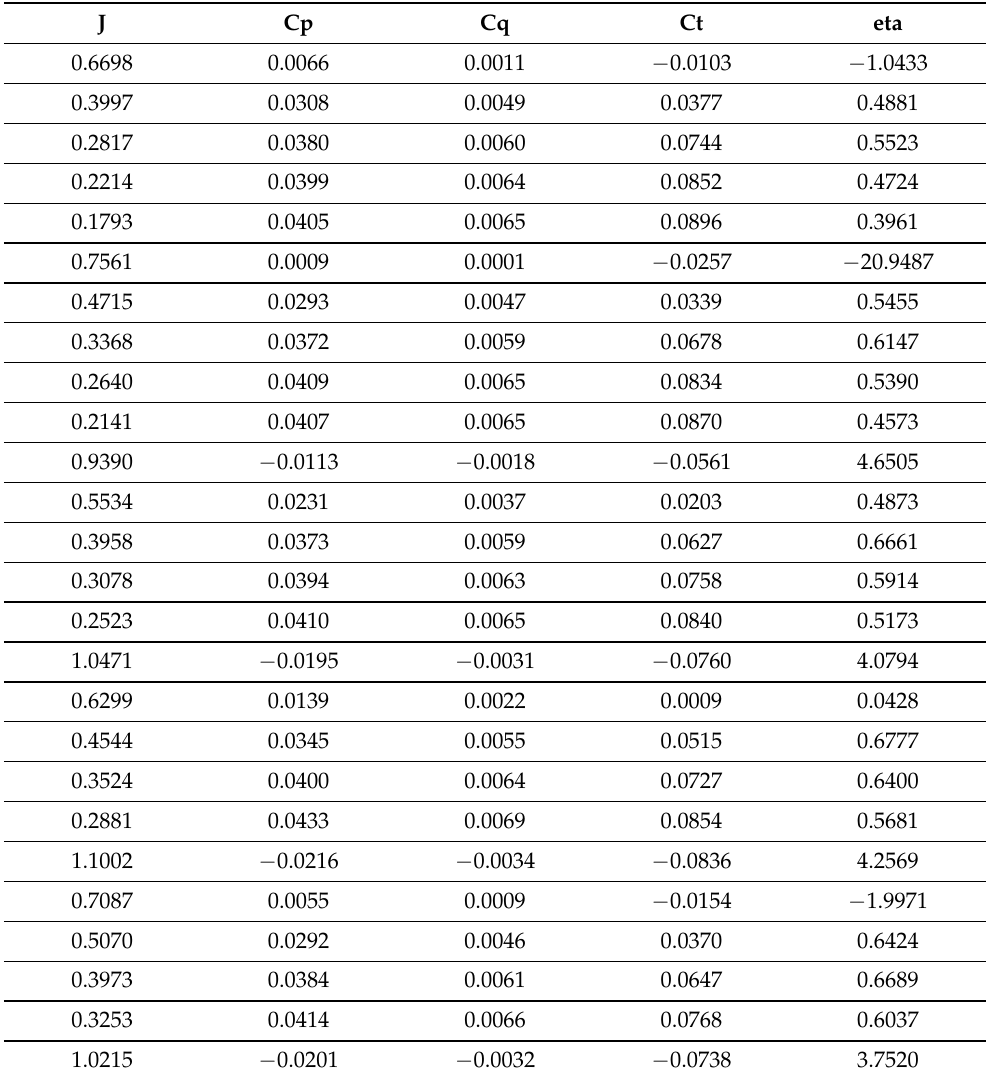
Table A11. APC 18 × 10 propeller wind tunnel processed